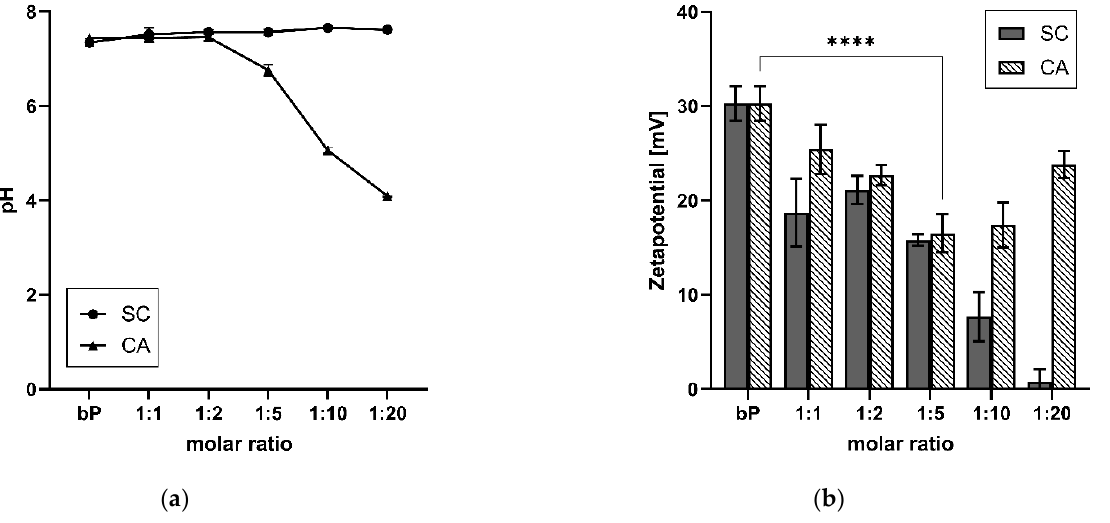
Figure 3. ( a ) Comparison of the influence of citric acid (CA) and sodium citrate (SC) on the pH of ternary proticles. ( b ) Zeta potential of CA- and SC-loaded ternary proticles in comparison to binary proticles (bP). Data are shown as mean values ( n = 3) ± standard deviation. It can be seen that applying CA at a molar ratio of 1:5 led to a highly significant (**** p < 0.001) decrease in the zeta potential. The molar ratio refers to a molar protamine:CA ratio.